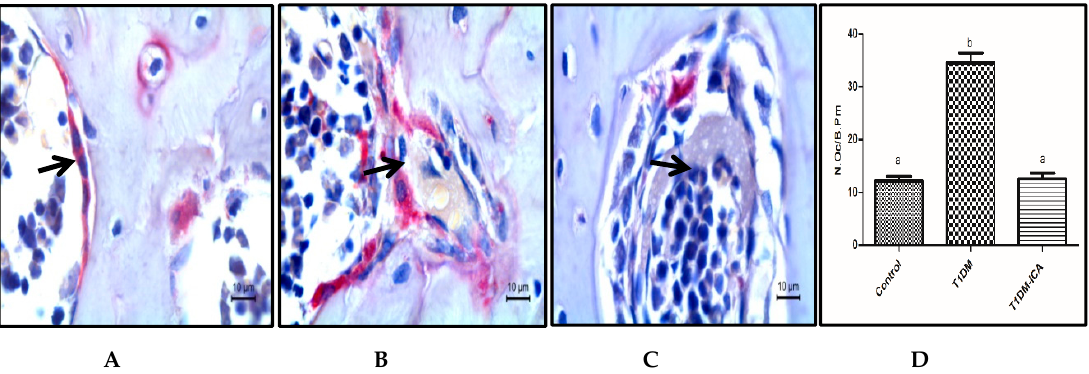
Figure 5. The number of osteoclasts per bone perimeter (N.Oc/B.Pm) in each group. ( A ) Osteoclasts in femur bone tissue of control group rat; ( B ) osteoclast in femur bone tissue of T1DM group rat; ( C ) osteoclast in femur bone tissue of T1DM-ICA group rat; ( D ) the number of osteoclasts per bone perimeter (N.Oc/B.Pm); Values are presented as means ± SD. Different letters indicate statistically significant difference ( p < 0.05). Femur bone tissue slides were stained by tartrate resistant acid phosphatase (TRAP), the black arrow points to osteoclasts.